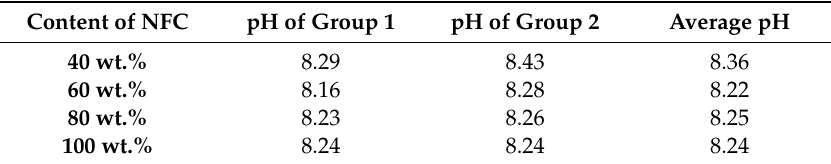
Table 1. pH of the suspension with di ff erent NFC contents.